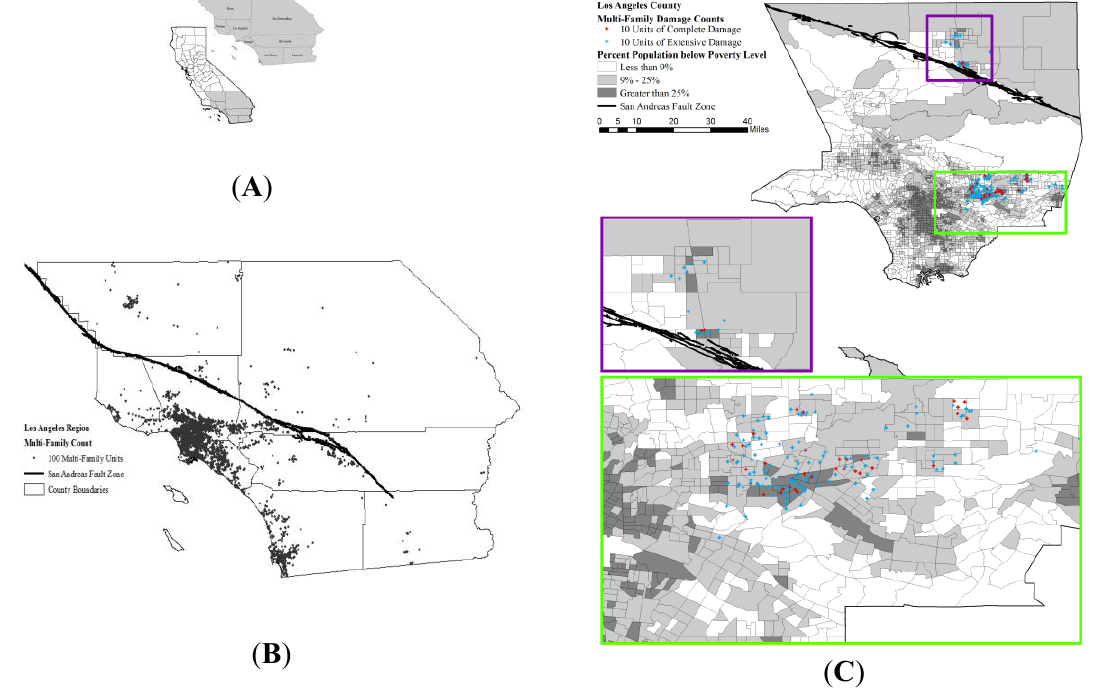
Figure 6. ( A ) Map of the USGS ShakeOut scenario region. ( B ) Map of the distribution of 100 multi-family units. ( C ) Map by census tract and poverty class of at least 10 multi-family housing units in the extensive and complete damages categories Los Angeles County (source: